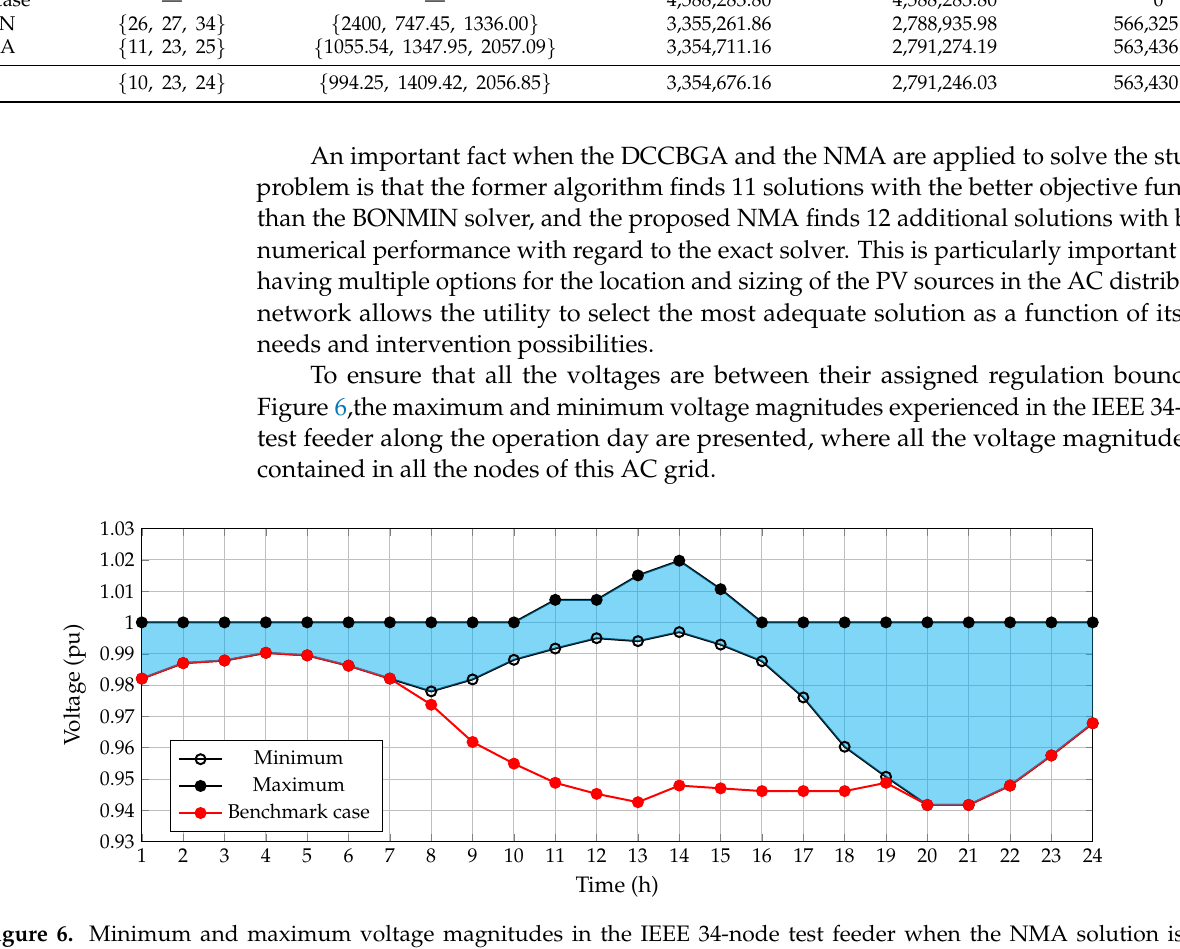
Table 4. Optimal locations and sizes provided by the GAMS and the proposed approach in the IEEE 34-bus system. Method Bench. case